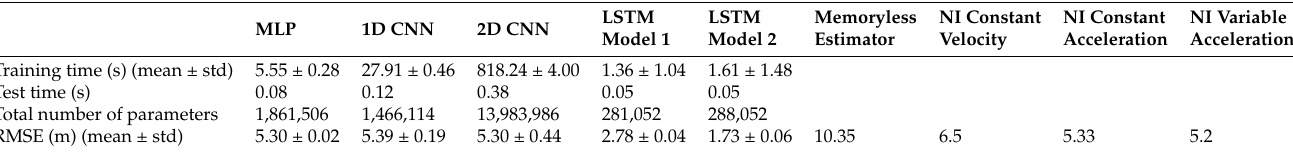
Table 6. Dynamic positioning error statistics for different